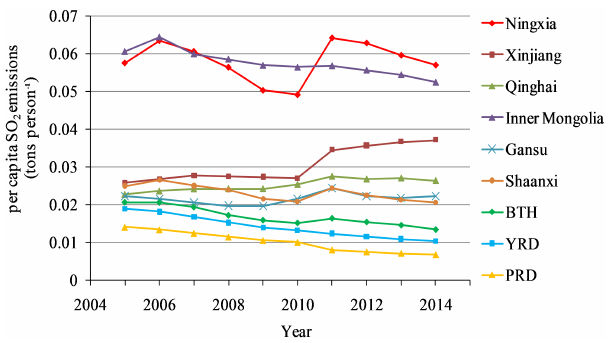
Figure 8. Per capita SO 2 emissions in six provinces of northwest- ern China and three key eastern regions (tperson − 1 ). The value for PRD refers to the per capita SO 2 emissions for Guangdong